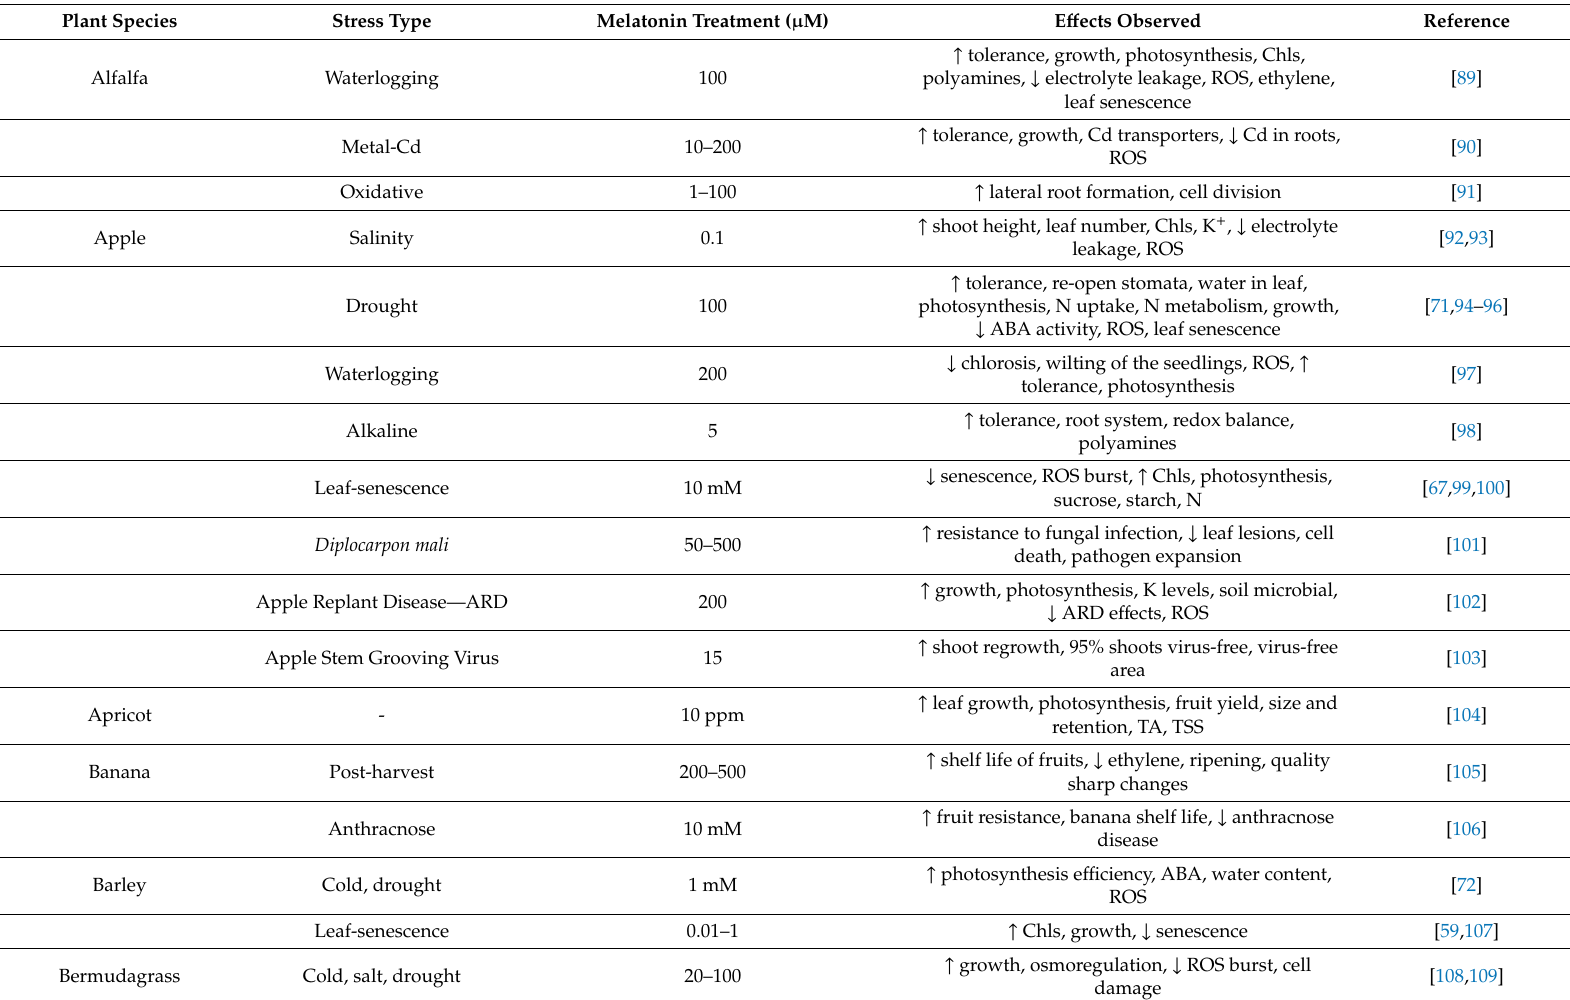
Table 1. Studies of di ff erent responses to melatonin treatments in di ff erent crop species in diverse stress